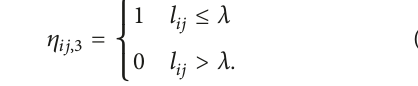
pedestrians becomes closer to the “face-to-face” case, the size is smaller, which would increase the time of of f avoidance ,𝑦 collision avoidance and deviate significantly from